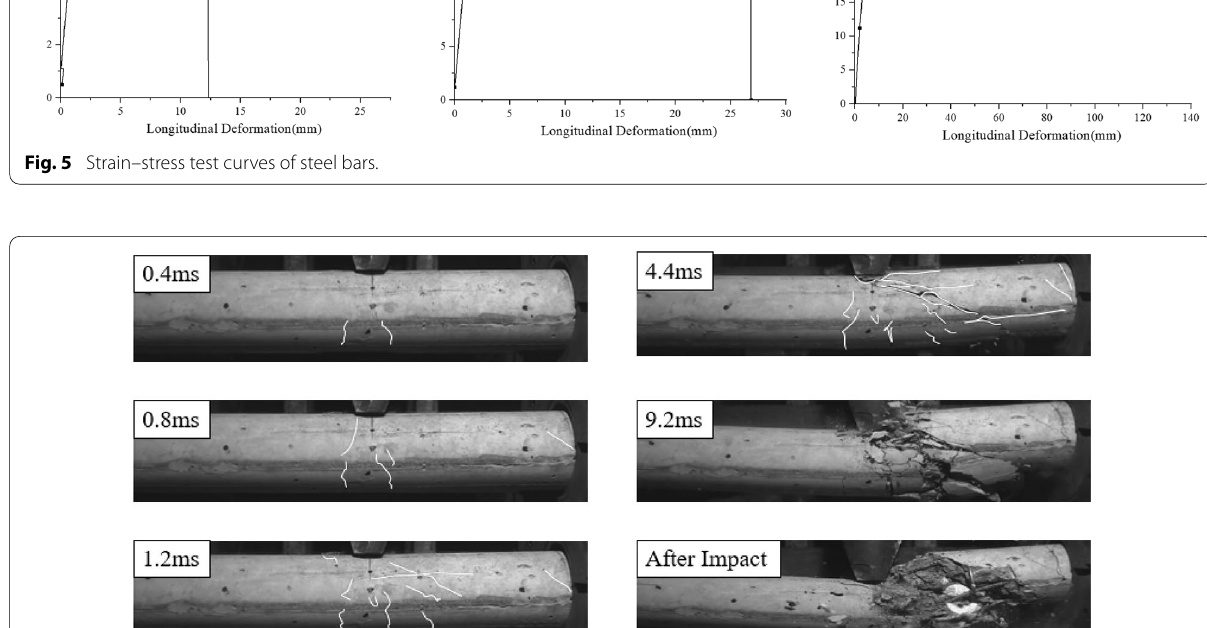
Fig. 6 YH1 crack development